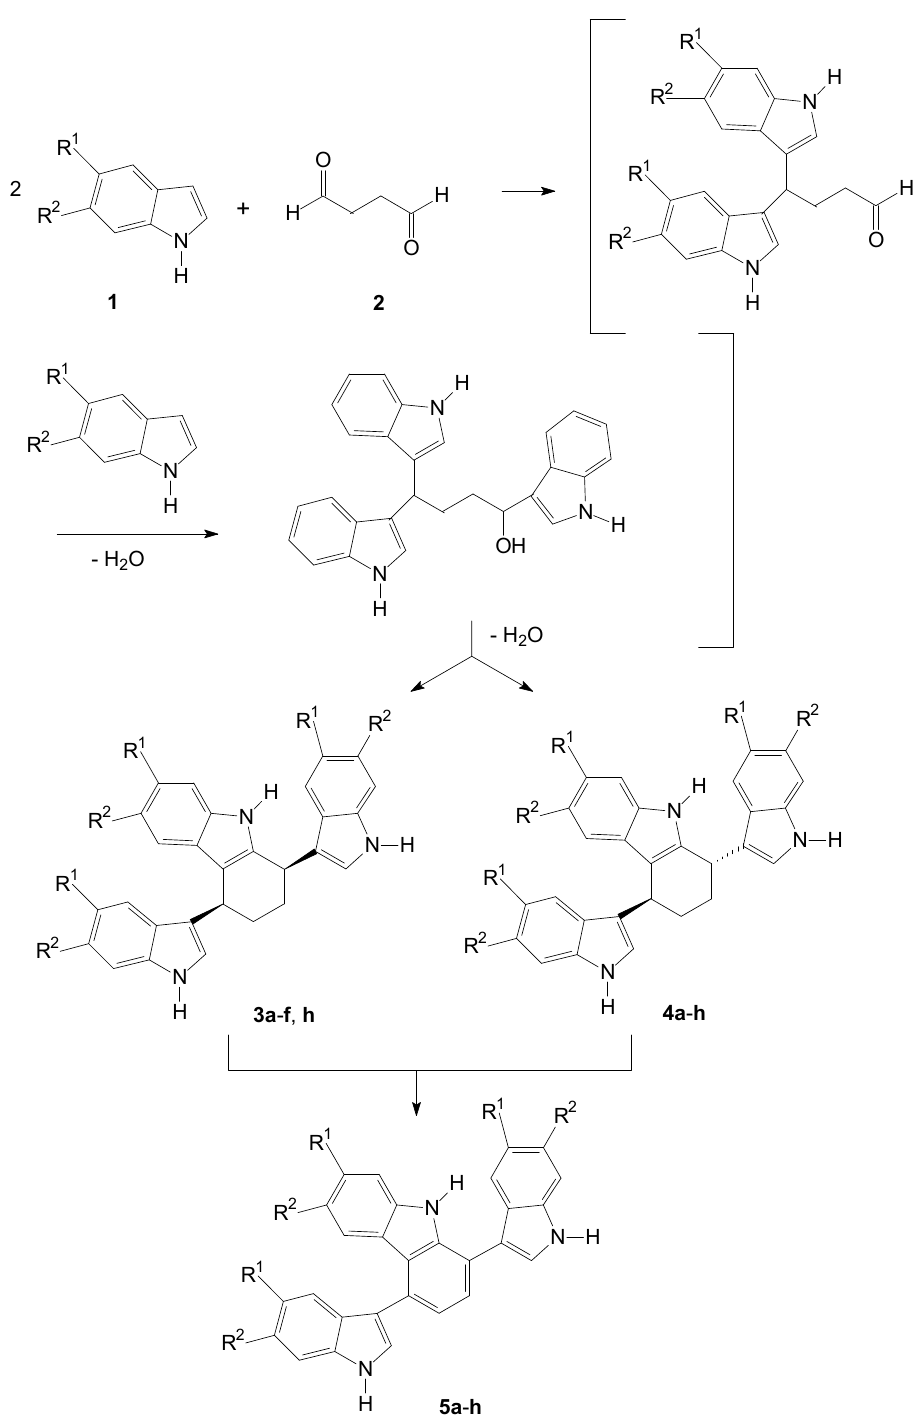
Scheme 1. Formation of Target